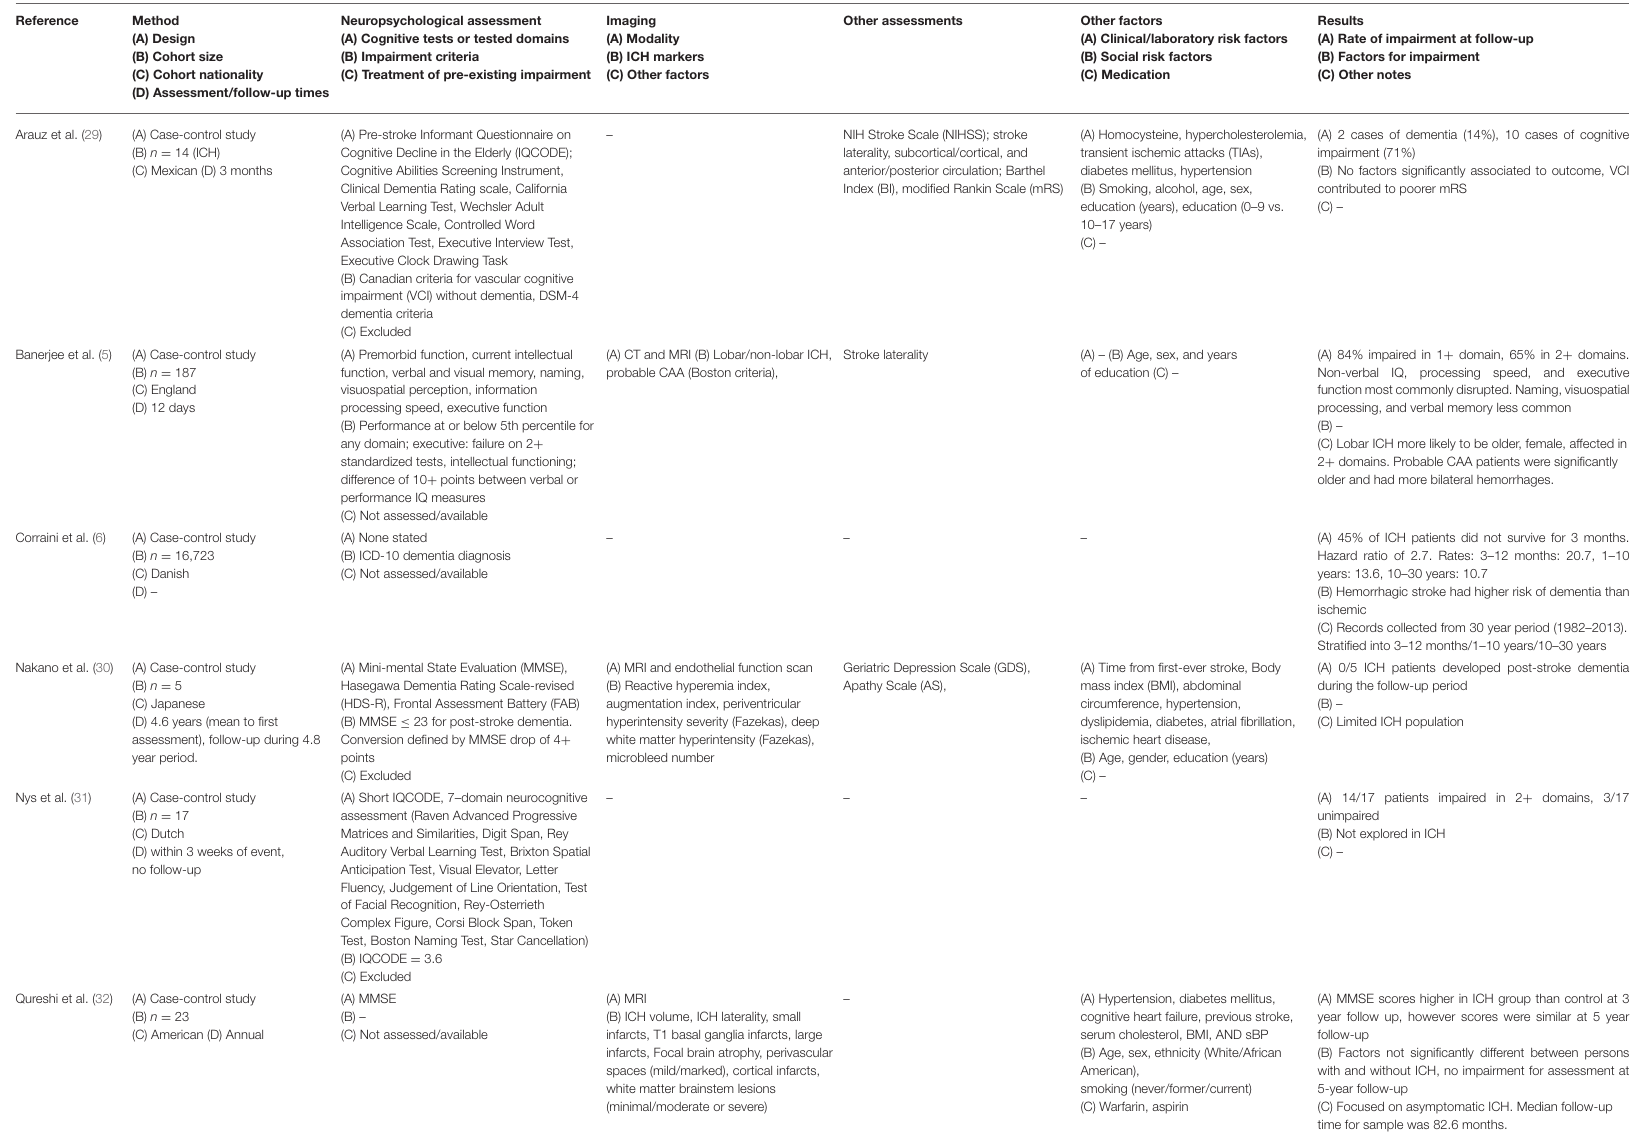
TABLE 2 | Summary of methods and findings from case-control